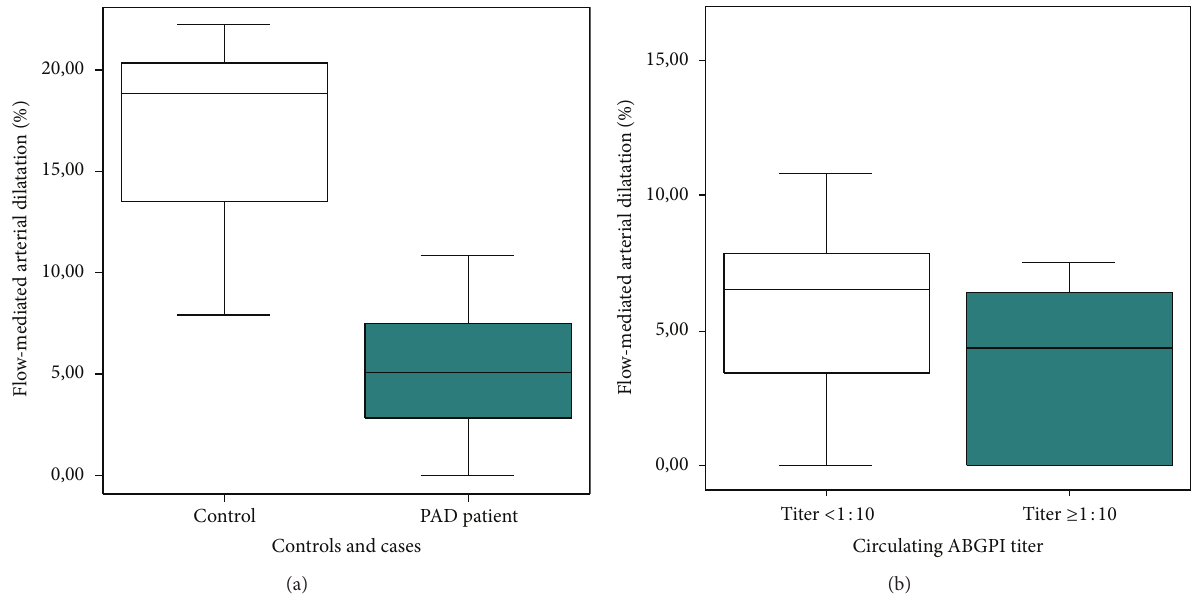
Figure 1: Flow-mediated arterial dilatation (FMAD) results. (a) Peripheral arterial disease patients showed lower FMAD values ( 𝑃 < 0.01 ). (b) FMAD was lower in patients with circulating anti-beta2-glycoprotein I antibodies (ABGPI) titer ≥ 1:10 ( 𝑃 = 0.01 ).